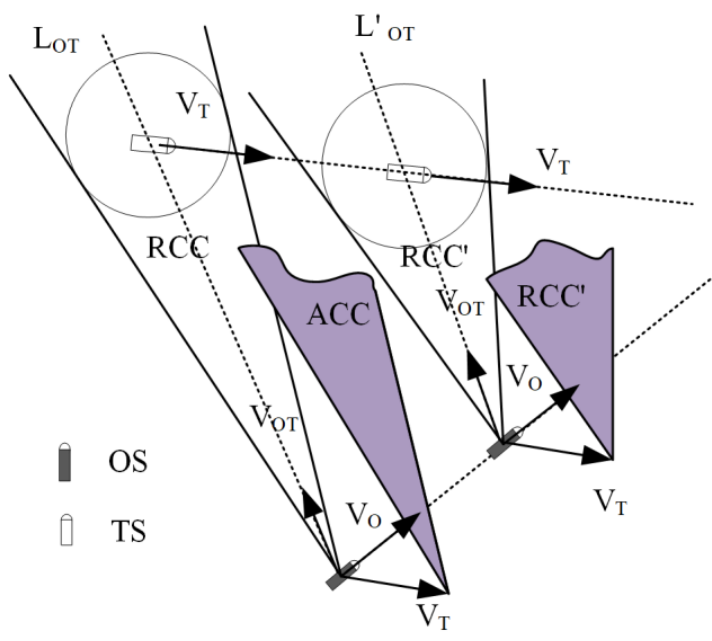
Figure 4. The diagram of the VO method.